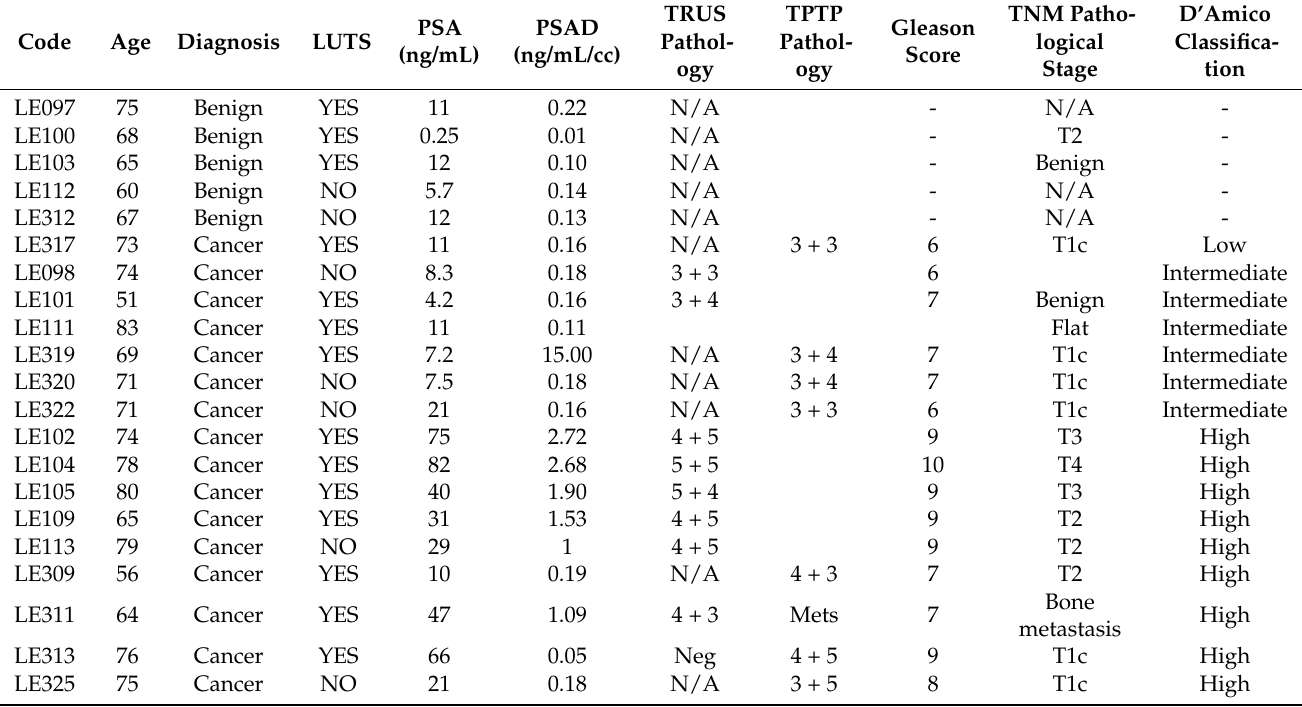
Table A3. Clinical information for men with benign prostate disease and prostate cancer (PCa). Ab- breviations: LUTS (Lower urinary tract symptoms), PSA (prostate-specific antigen), PSAD (Prostate- Specific Antigen Density), TRUS (Transrectal Ultrasound-guided biopsy), TPTP (Transperineal Tem- plate Prostate biopsy).